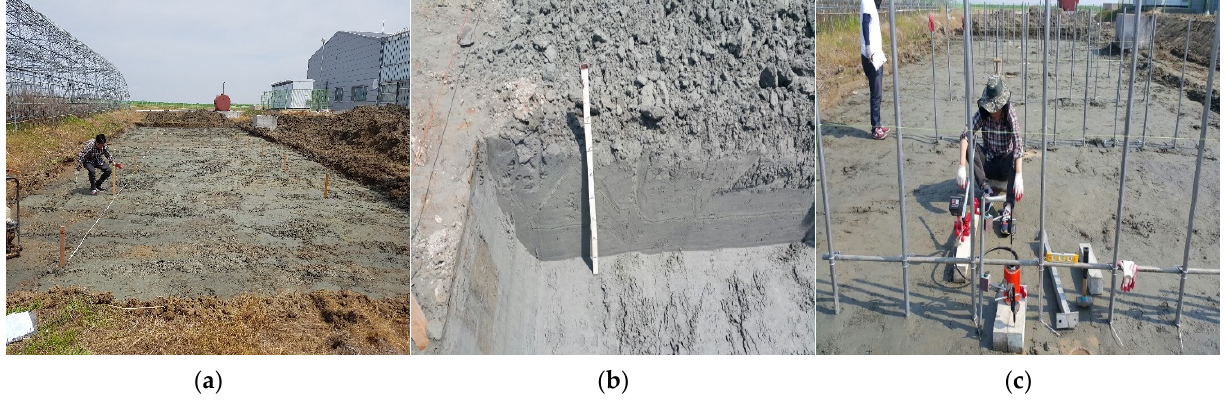
Figure 6. Field test procedure of site C: ( a ) ground grading work; ( b ) embedded depth leveling; ( c ) uplift testing of continuous foundations.